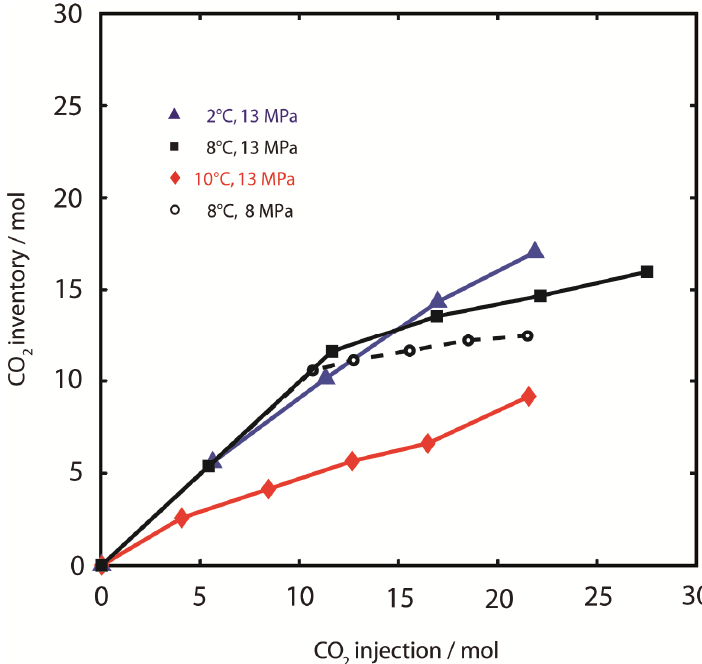
Figure 5. CO -retention. CO sample inventory during injection of CO 2 2 efficiency was highest at 2 °C, 13 MPa ( ▲ ). Rapid CO 10 °C, 13 MPa ( ♦ ). CO retention efficiency at 8 °C ( ■ , 13 MPa and ○ , 8 MPa) was 2 dependent on pressure conditions.